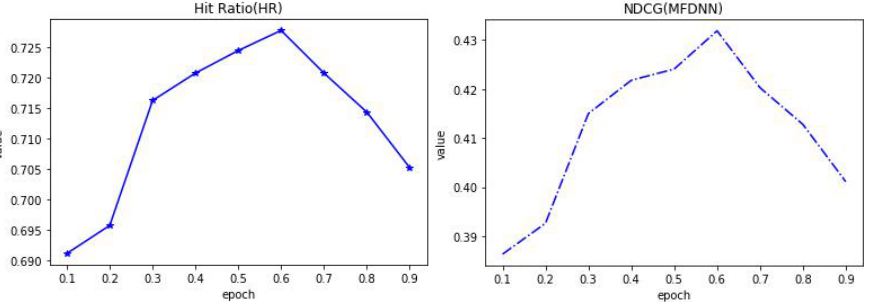
Figure 8. The HR and NDCG values for different dropout rates.